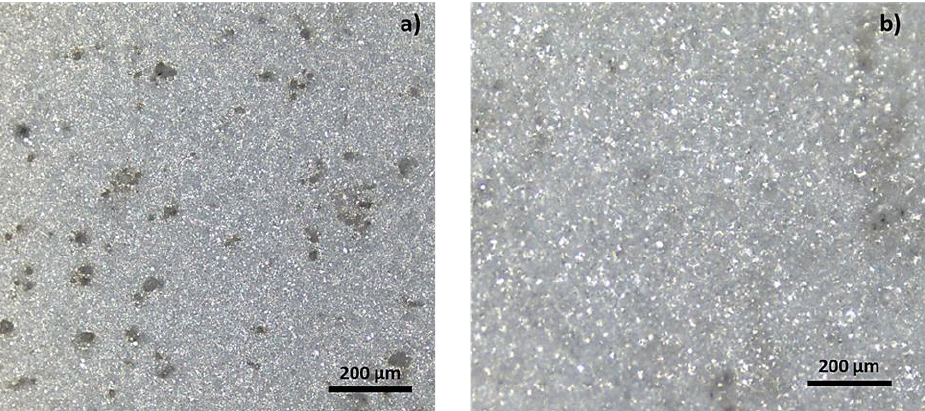
Figure 8. Surface appearance optical images after potentiodynamic polarization test in Hank’s solution at 37 °C of the ( a ) MG_PEO15 and ( b ) Mg_PEO30 samples.